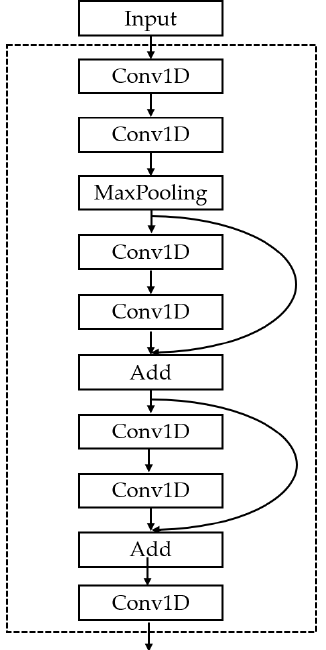
Figure 5. The 1D-CNN model structure. (3) RNN